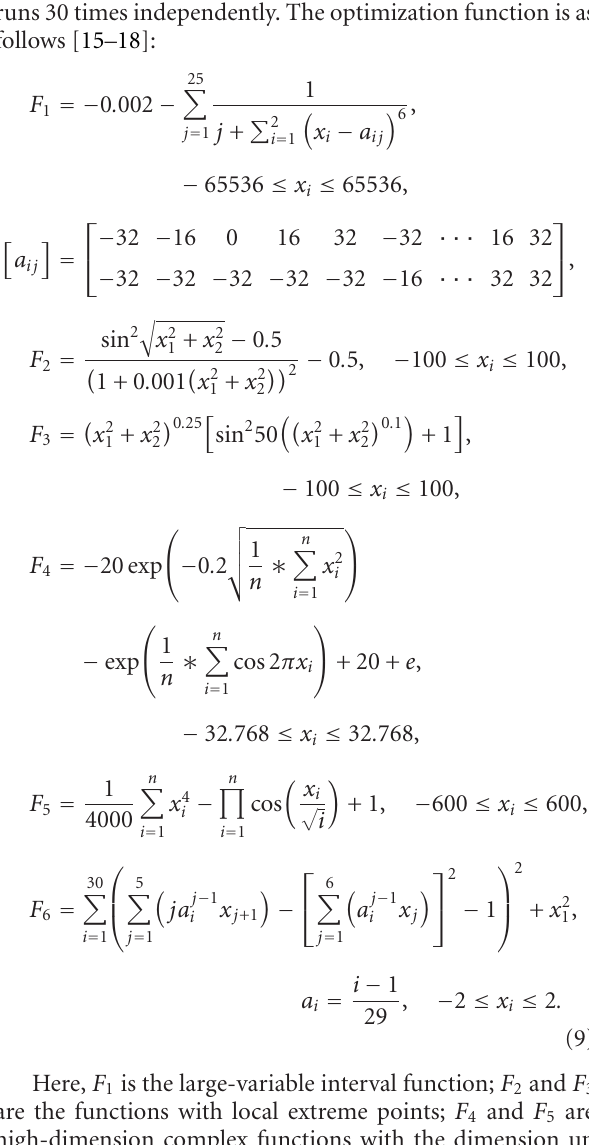
algorithm (Algorithm 2) based on the evolution